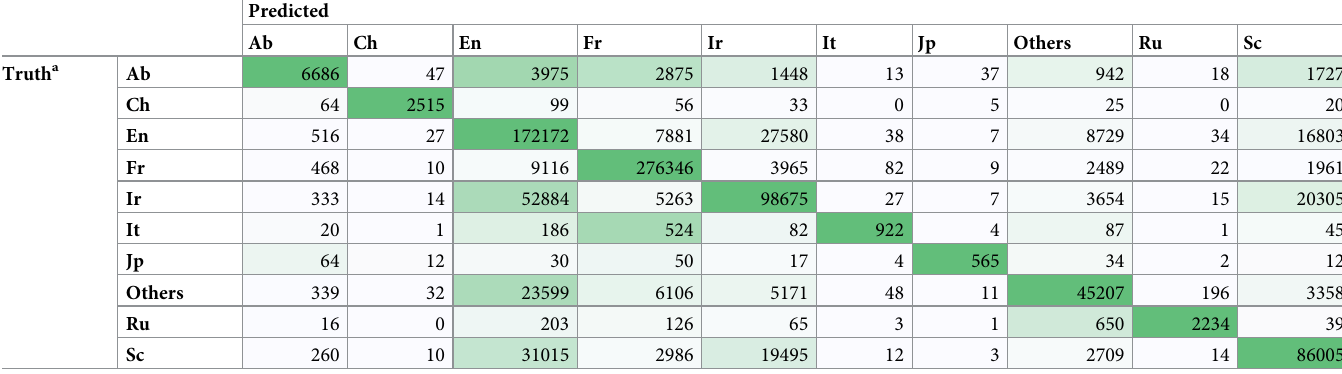
Table 5. Multiclass confusion matrix in test set for the “All name features” set trained in training set with regularised logistic regression classifier.